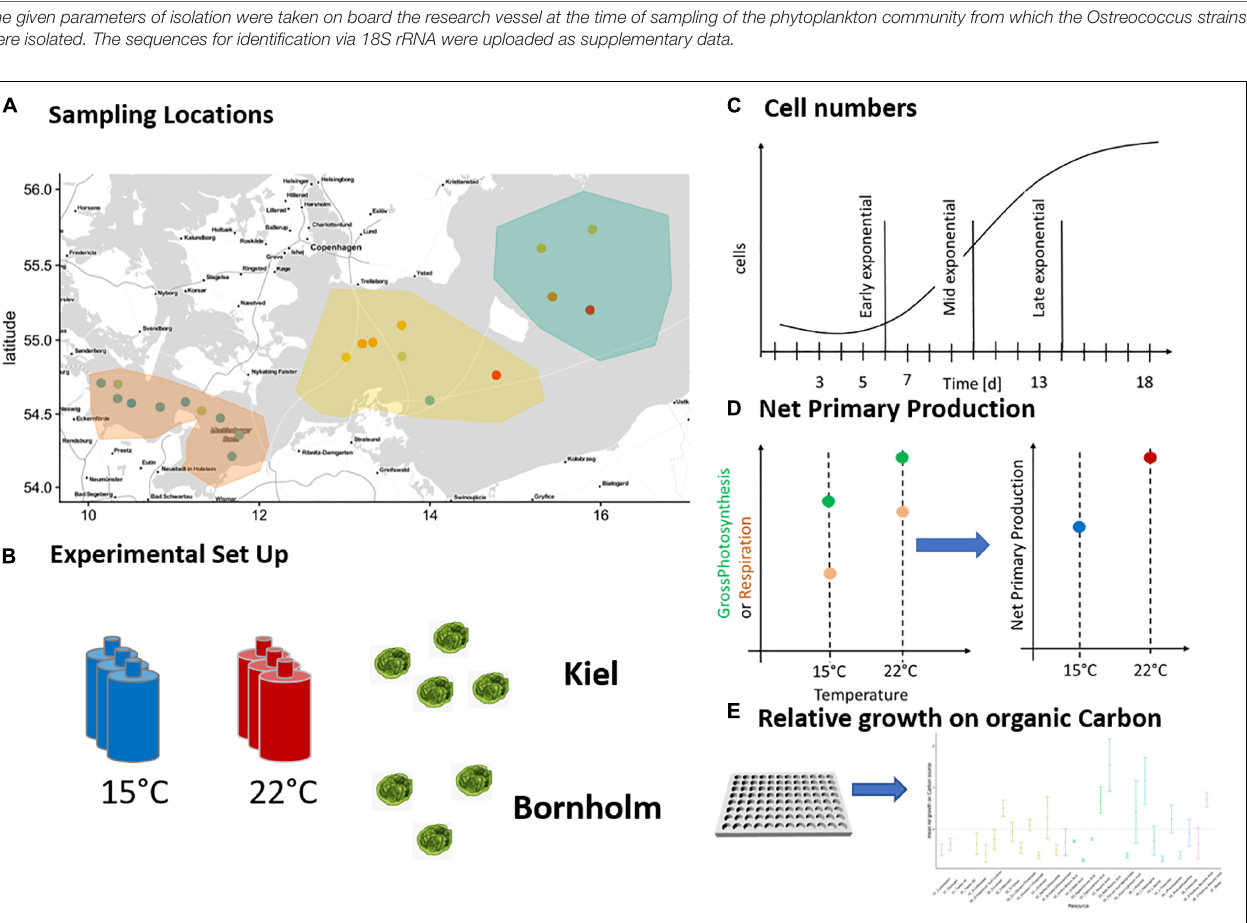
FIGURE 1 | Sampling locations and experimental set-up: The pico-phytoplankton communities from which we isolated Ostreococcus sp. were collected during two research cruises in March and August 2018 and originate from Kiel area and Bornholm Basin (A) . Eight successfully isolated strains of Ostreococcus sp. were exposed to 15 and 22 ◦ C (B) in four consequent experiments and monitored daily for growth via tracking cell numbers (C) . In addition, we measured net primary production daily (D) in experiments 1–3 and in experiment 4 we investigated potential growth on organic carbon at three time points of the microbial growth curve